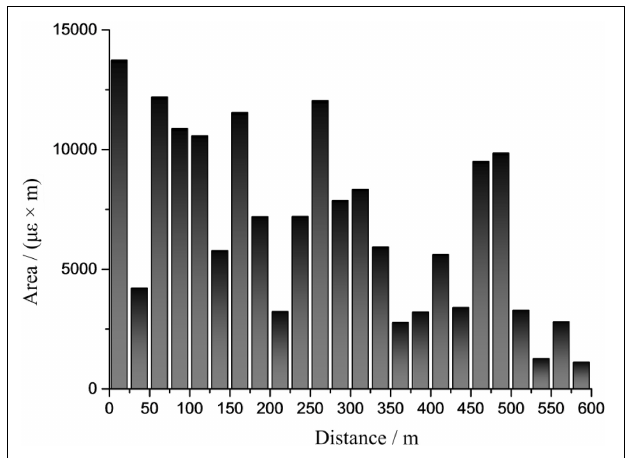
FIGURE 11 | The different area values along the optical fiber line.